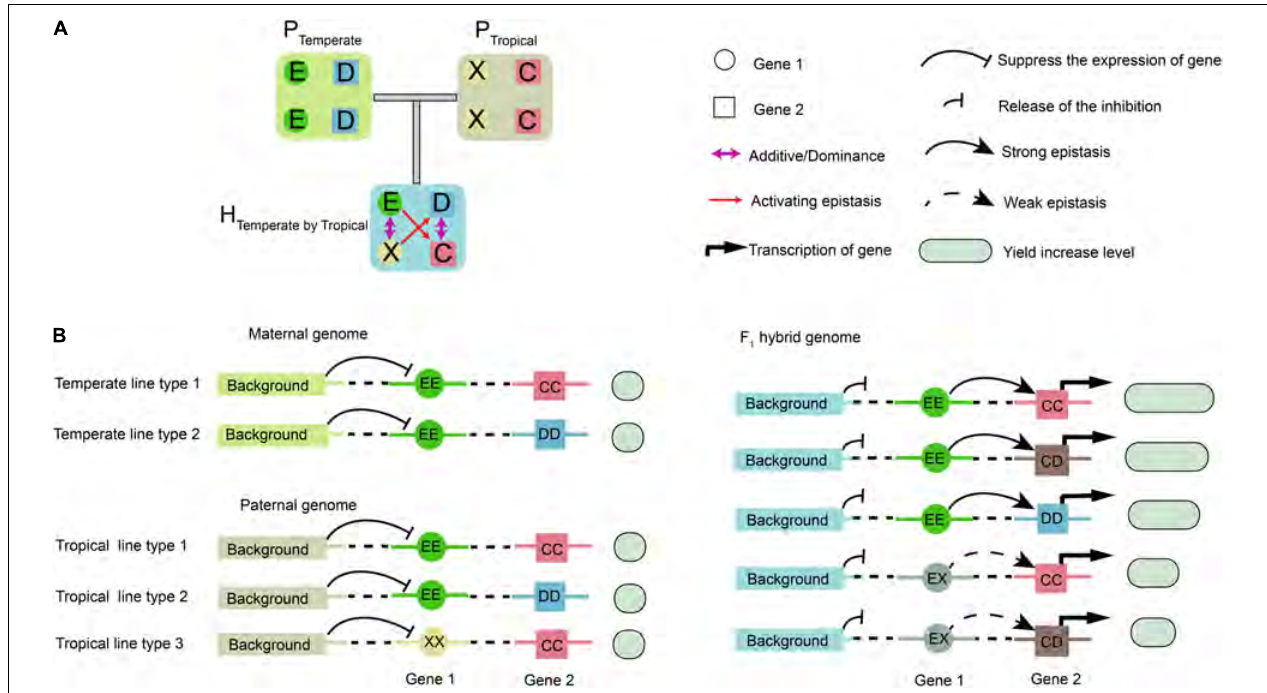
FIGURE 8 | Schematic illustration of epistatic effects. (A) Epistasis does not occur between temperate parental (P Temperate ) or tropical parental (P Tropical ) lines due to their homozygous genotypes. When two types of inbred lines are crossed, the genetic background in the hybrid changes, resulting in epistatic interaction between the two genetic loci, Gene 1 and Gene 2, which have additive and dominant effects. (B) A putative model for interpretation of the interactions between Gene 1, Gene 2, and background genes. In the parental inbreds, background genes repress the transcription of Gene 1. In the hybrid, the repression effect on Gene 1 is relieved, and its transcripts activate the expression of Gene 2. Then, transcription of Gene 2 is activated with different expression levels. The genetic background determines upstream protein–protein interactions specific to the F 1 hybrids, and the E, D, X, and C in a circle or square represent different alleles. The yield associated with the epistasis is measured by the sizes of the empty circles and boxes in light